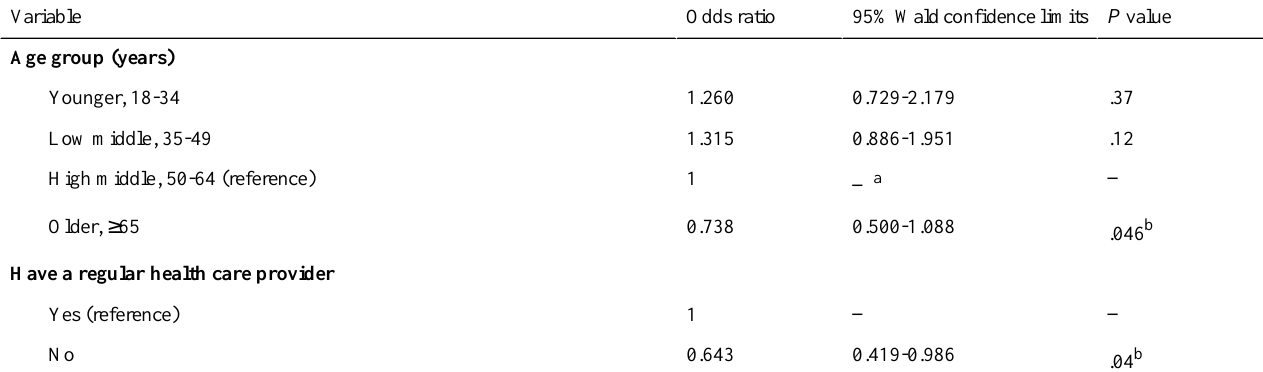
Table 2. Interest in medical research by sociodemographic characteristics, health behaviors, and information-seeking